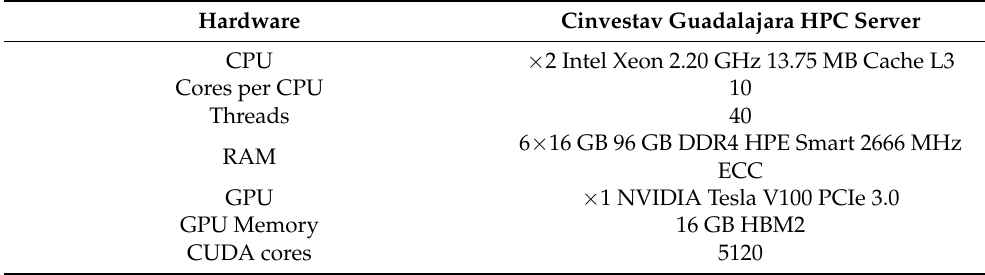
Table 3. Hardware of HPC server for experiments.